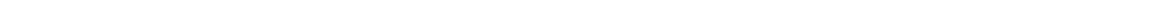
Fig. 4 MAIT cell cytokine and transcription factor pro fi les during Legionella infection. a Representative fl ow cytometry plots showing intracellular staining for IL-17A, IFN- γ and GM-CSF by pulmonary TCR β lymphocytes (non-MAIT conventional and MAIT cells) after 4 h of culture (direct ex vivo, top panel or with PMA/ionomycin stimulation, second panel) with brefeldin A. Lymphocytes were harvested from lungs of C57BL/6 mice infected with 2 × 10 4 CFU L. longbeachae for 7 days. Percentages in brackets represent the proportion of MR1-tetramer-positive MAIT cells expressing cytokine. b Percentages and c absolute numbers of pulmonary MAIT cells producing IL-17A, IFN- γ or GM-CSF by intracellular staining, directly ex vivo from C57BL/6 mice infected for 0, 7 or >100 days with 2 × 10 4 CFU L. longbeachae . Data were pooled with 5 – 9 mice per group (mean ± SEM) from 3 independent experiments. MAIT frequencies are compared using one-way ANOVA with post hoc Tukey ’ s. * P < 0.05, ** P < 0.01, *** P < 0.001, **** P < 0.0001. d Representative fl ow cytometry plots of MAIT cells expressing T-bet and ROR γ t. e Average proportion of T-bet + , ROR γ t + , double positive (DP) and double negative (DN) MAIT cells from uninfected or infected C57BL/6 mice at indicated date. Mean values of 5 – 9 mice in each group from 3 independent experiments. See also Supplementary fi gure 7C, 7D for individual data points. Mice were either naive or infected similarly as in